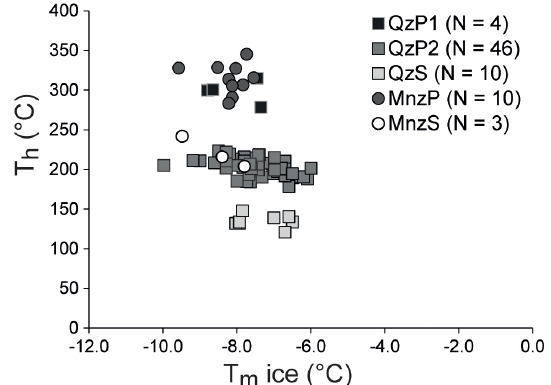
Figure 4. The T h vs. T m ice diagram of the fluid inclusions data. QzP1: population 1 of primary fluid inclusions in quartz; QzP2: population 2 of primary fluid inclusions in quartz; QzS: secondary fluid inclusions in quartz; MnzP: primary fluid inclusions in mon- azite; MnzS: secondary fluid inclusions in monazite.